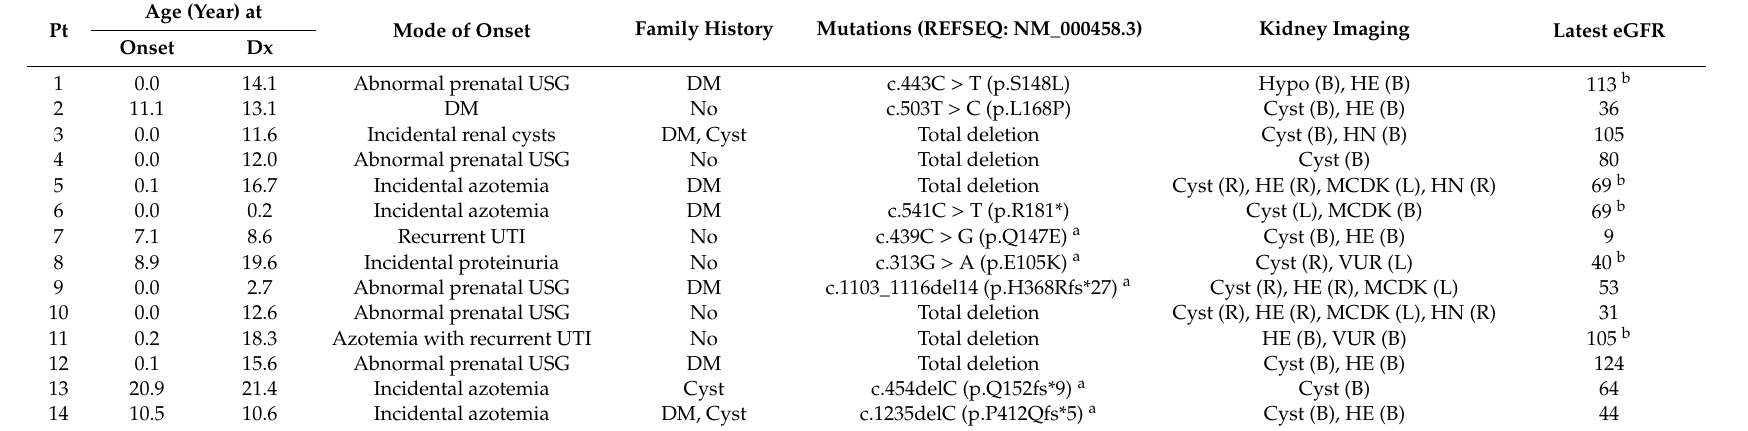
Table 1. Genotypes and renal phenotypes of the